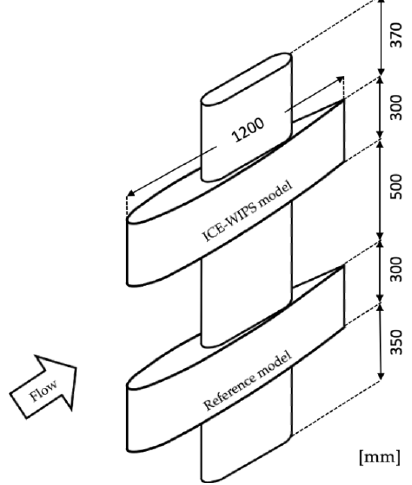
Figure 5. Schematic of the demonstration models in the test section.